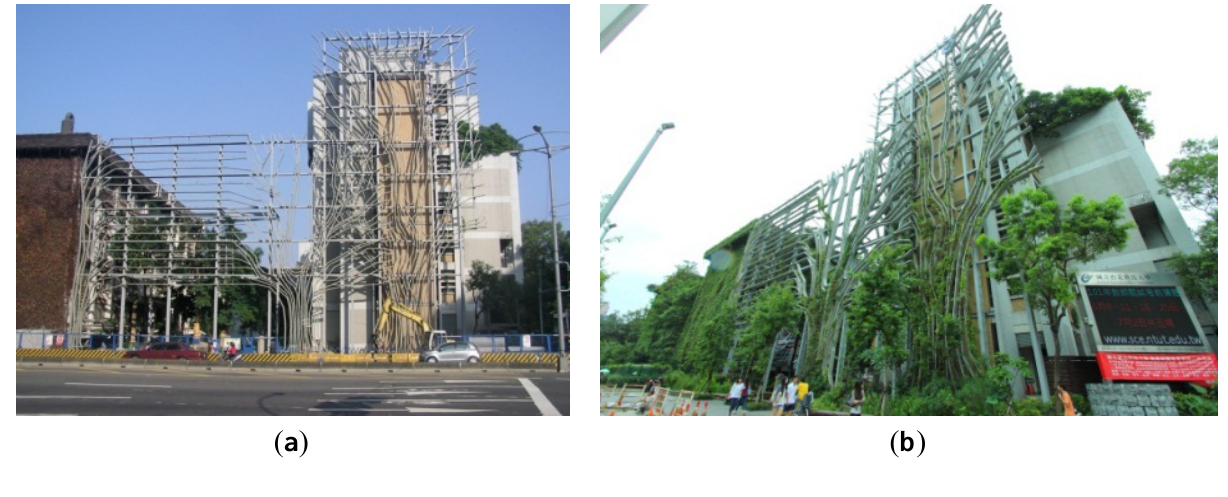
Figure 4. Case study: A building shielded by a vertical garden system (VGS) saves